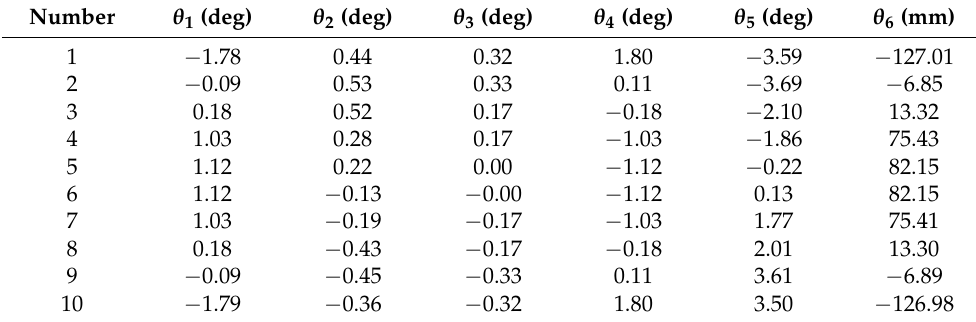
Table 2. The motion of joints on the right side of the vehicle’s secondary system.